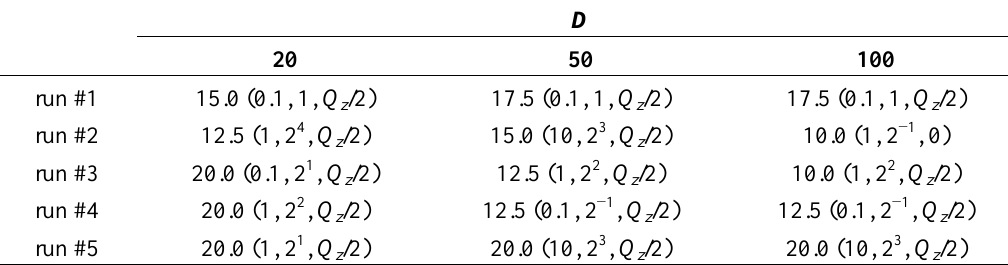
Table 3. Simulation results: problem C, tensor-SVM.